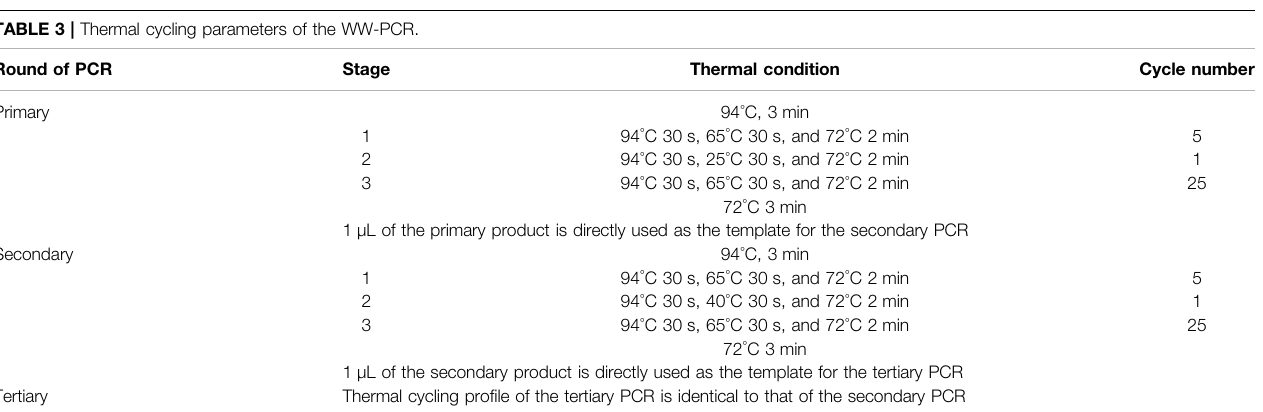
TABLE 3 | Thermal cycling parameters of the WW-PCR. Round of PCR